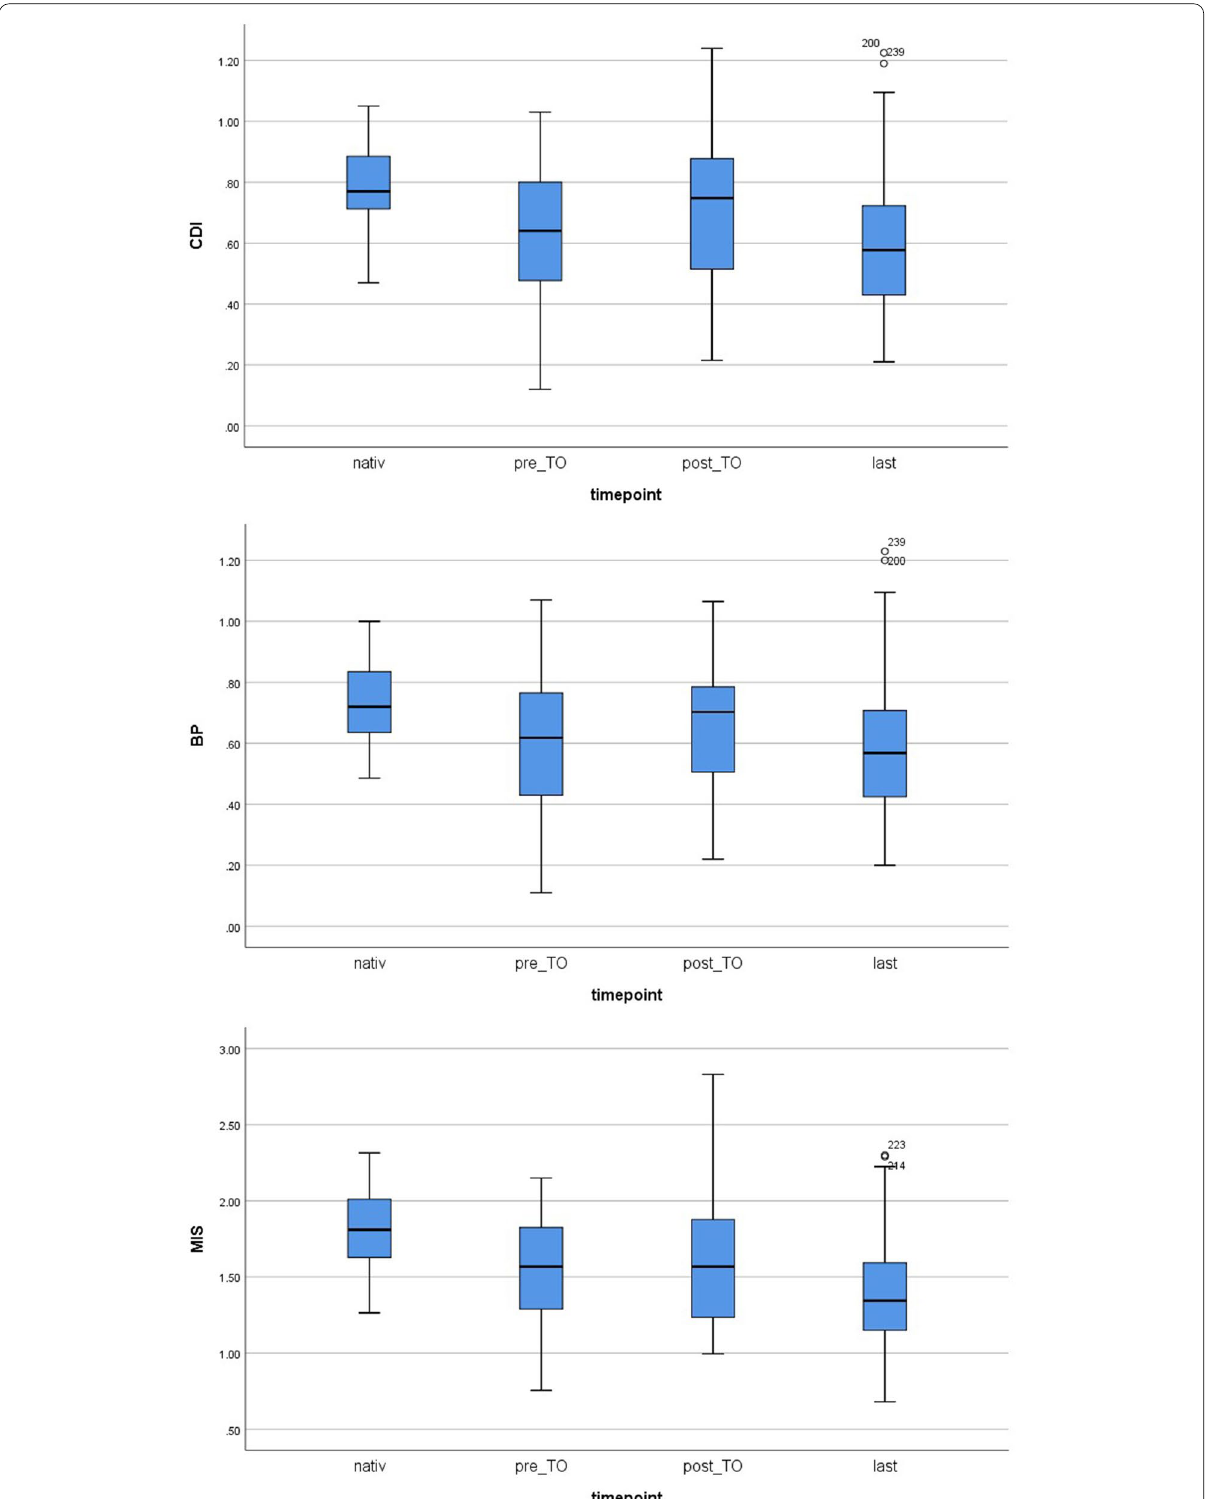
Fig. 4 Comparison of the Caton-Deschamps index (CDI), Blackburne-Peel ratio (BP), and modified Insall-Salvati index (MIS) at various